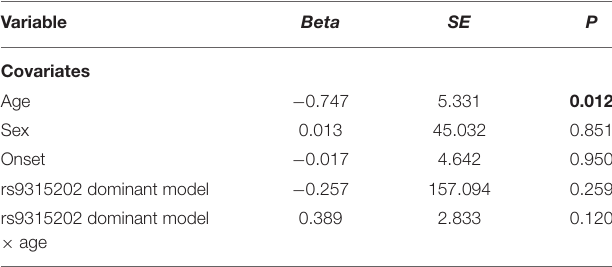
TABLE 4 | Regression results from models with significant interactive effects of rs9315202 dominant model and age on plasma α -Klotho concentration ( n =